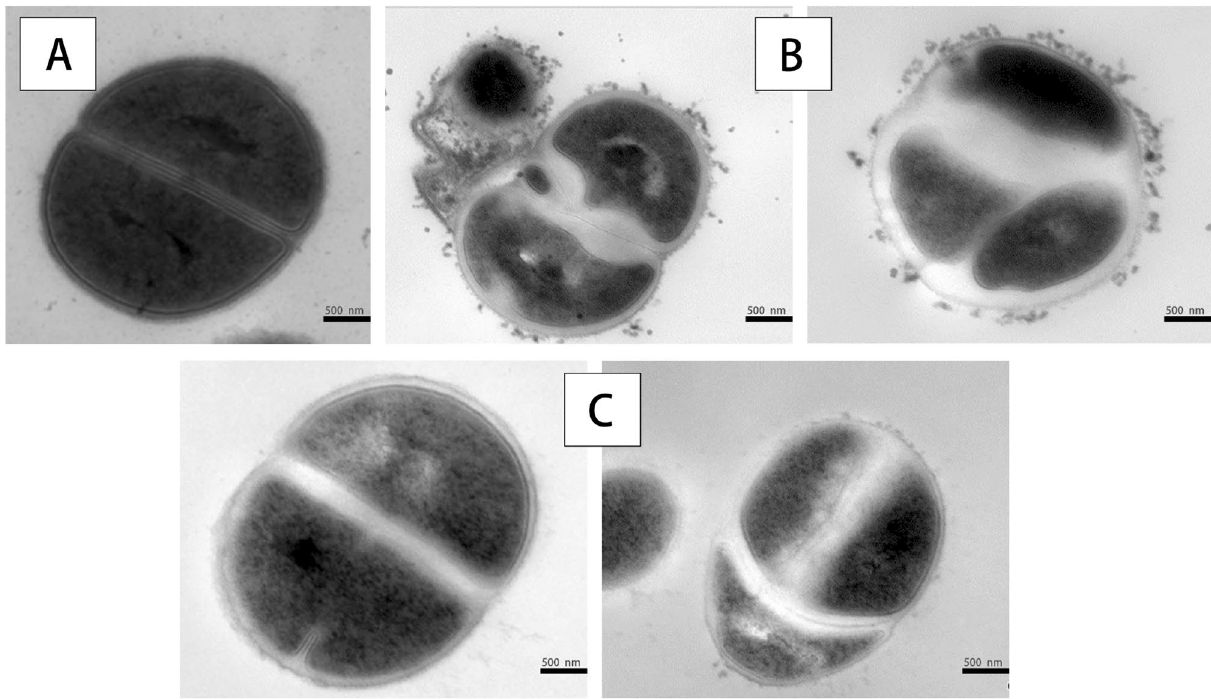
Figure 5. Morphological structure of S. aureus observed by TEM, untreated ( A ); VTE treatment 12 h ( B ); DMY treatment 12 h ( C